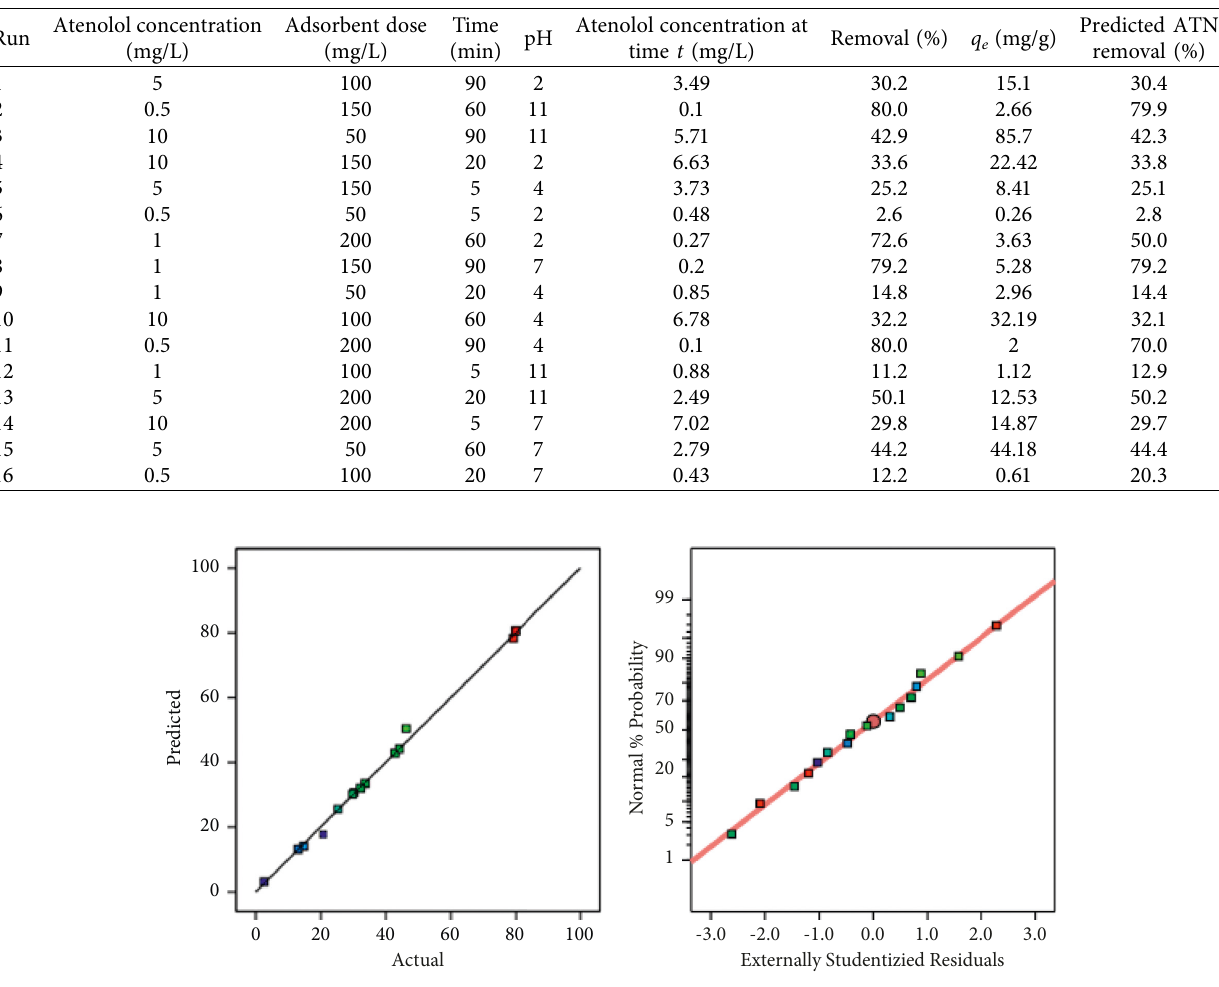
Table 3: Test condition and the efficiency of laboratory and predicted removal.